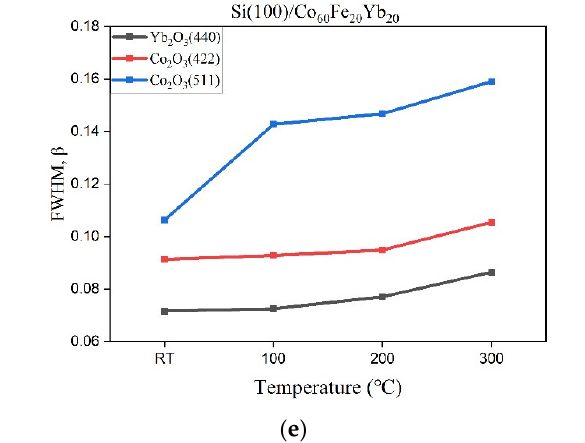
Figure 1. XRD patterns of CoFeYb films. ( a ) RT, ( b ) after annealing at 100 °C, ( c ) after annealing at 200 °C, ( d ) after annealing at 300 °C. ( e ) FWHM of oxide peaks in CoFeYb 40 nm at various conditions.